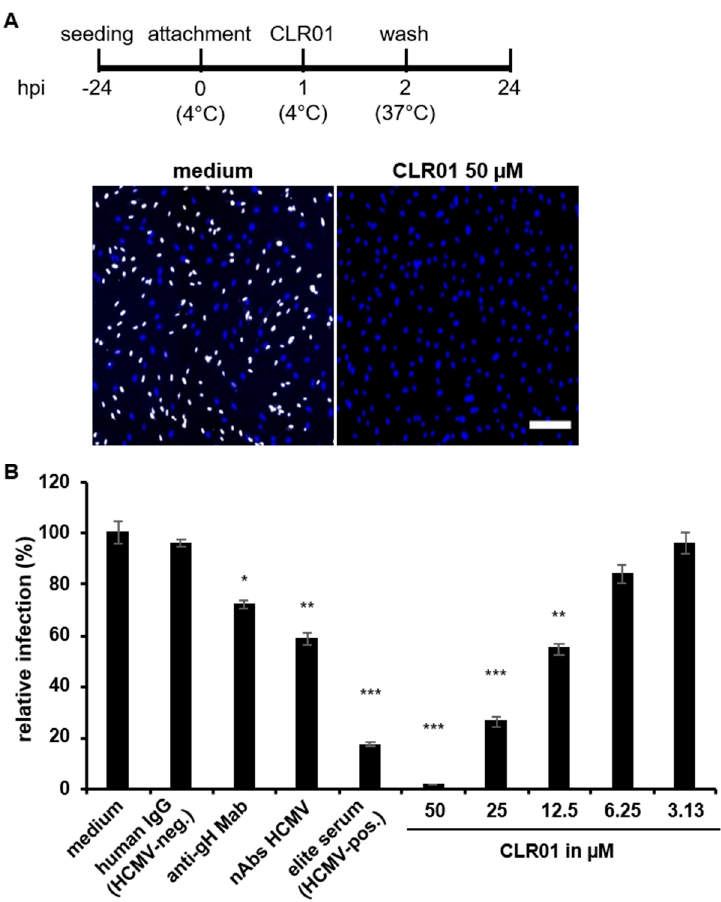
Figure 3. CLR01 blocks viral infection post attachment. ( A ) Cell-free virus particles of HCMV (strain TB40/E) were attached to human fibroblasts for 1 h at 4 °C prior to addition of either 50 µM CLR01 or medium for another hour at 4 °C. Infection was determined at 24 hpi by detection of HCMV IE antigen after the shift to 37 °C. Blue, DAPI-positive cells; white, HCMV-positive cells. Scale bar is 200 µm. ( B ) Quantification from A with additional controls (neutralizing Abs (nAbs, 5 mg/mL Gamunex), anti-gH Abs (10 µg/mL), human IgG (HCMV negative, 10 µg/mL), elite human serum (HCMV positive, 1:10)), and indicated concentrations of CLR01. Means ± SDs of relative infection are from the combined results of two individual experiments, each performed in triplicate. Controls (medium) were set to 100% and samples normalized accordingly. *, p < 0.01; **, p < 0.001; ***, p < 0.0001.